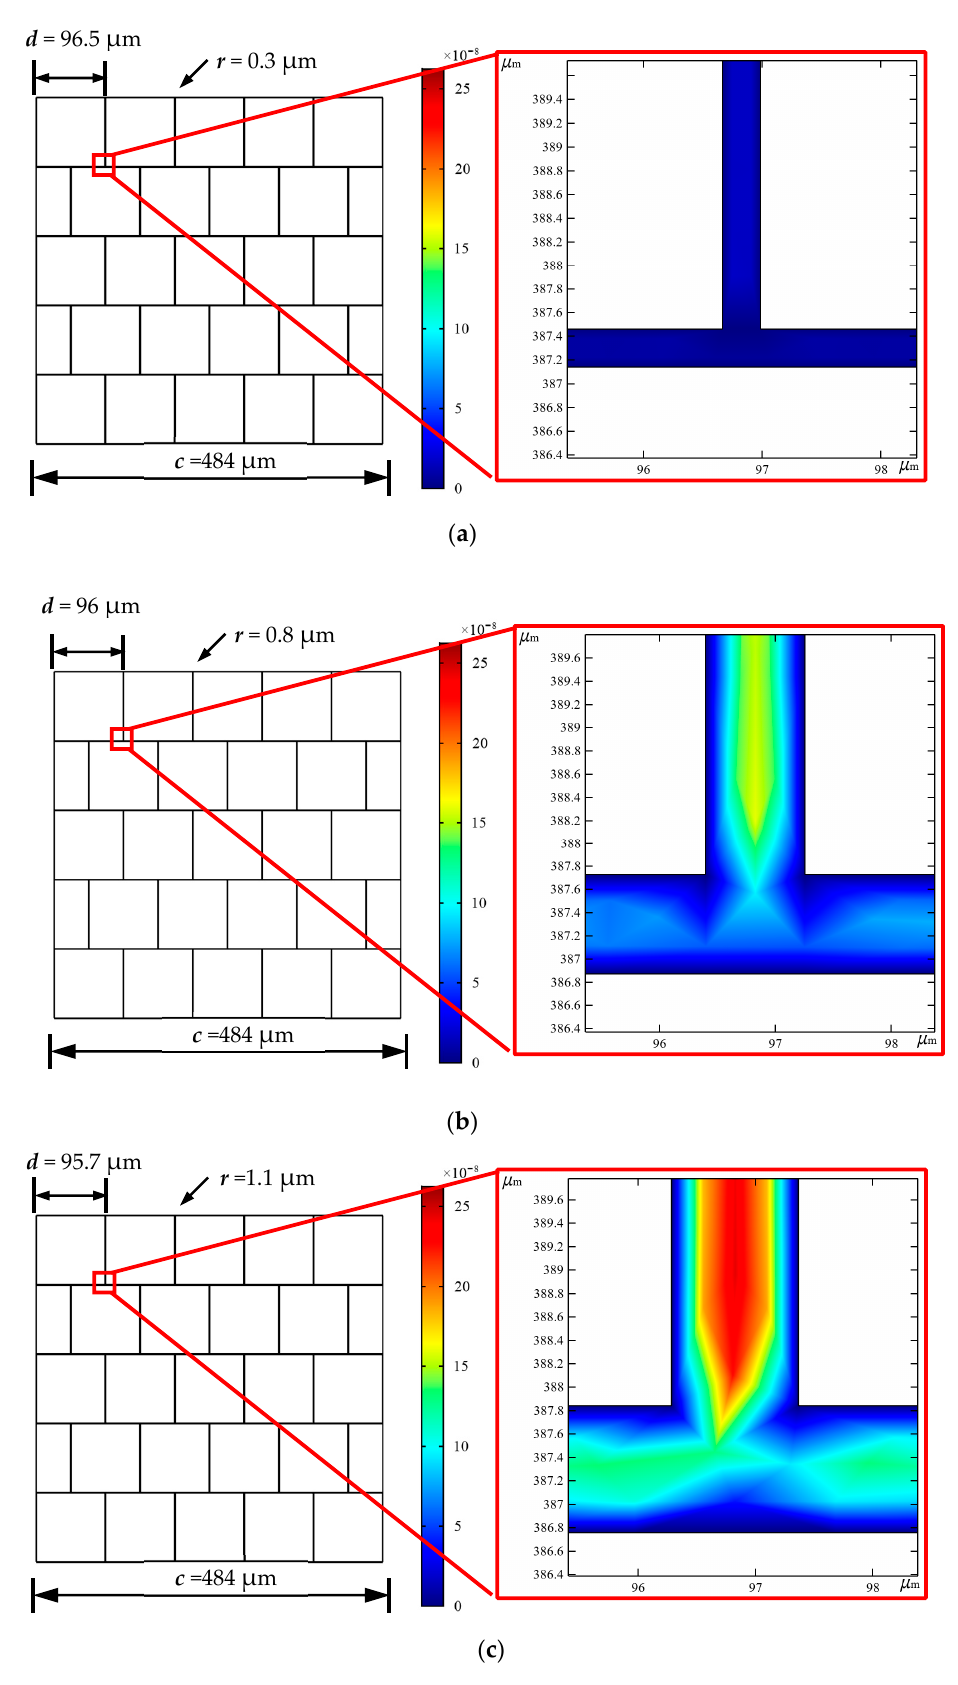
Figure 8. COMSOL model diagram (white: bentonite; Color: permeating solution). ( a ) I = 0.1 mol/L; n f = 0.012; ( b ) I = 0.5 mol/L; n f = 0.0176; ( c ) I = 1 mol/L; n f = 0.022.